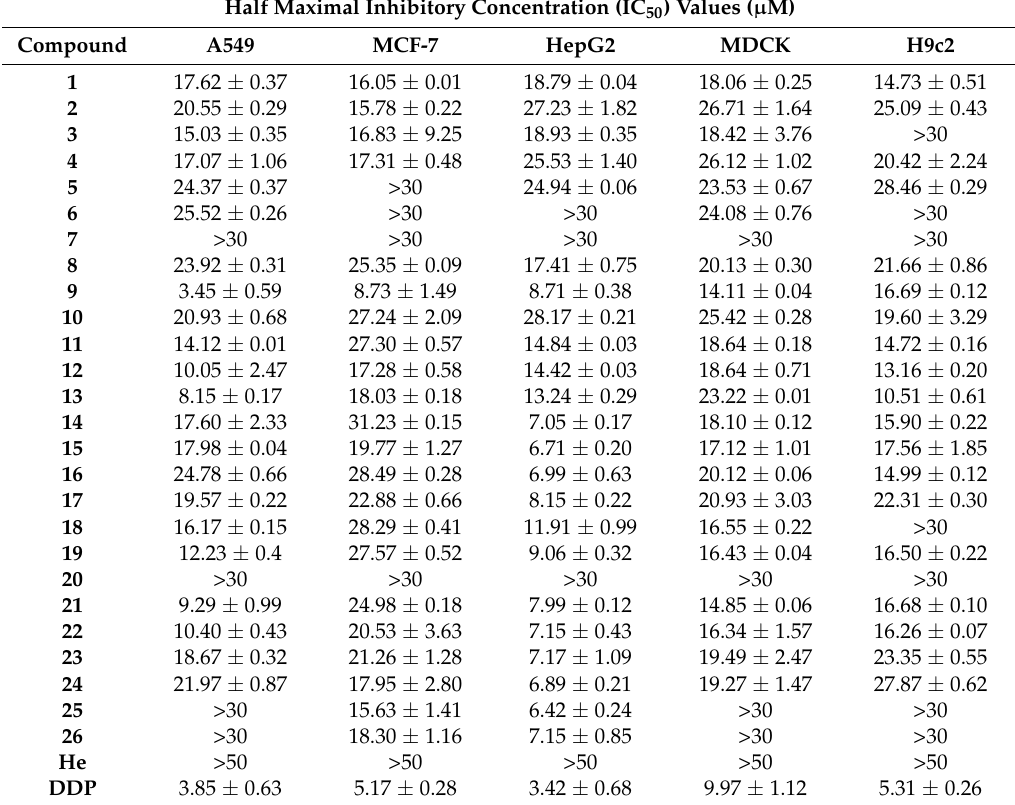
Table 1. The in vitro cytotoxicity of compounds against various cell lines. A549—human non-small- cell lung cancer; MCF-7—human mammary cancer; HepG2—human hepatocellular carcinoma; MDCK—Madin–Darby canine kidney; H9c2—murine heart myoblast; He —hederagenin; DDP —cisplatin.